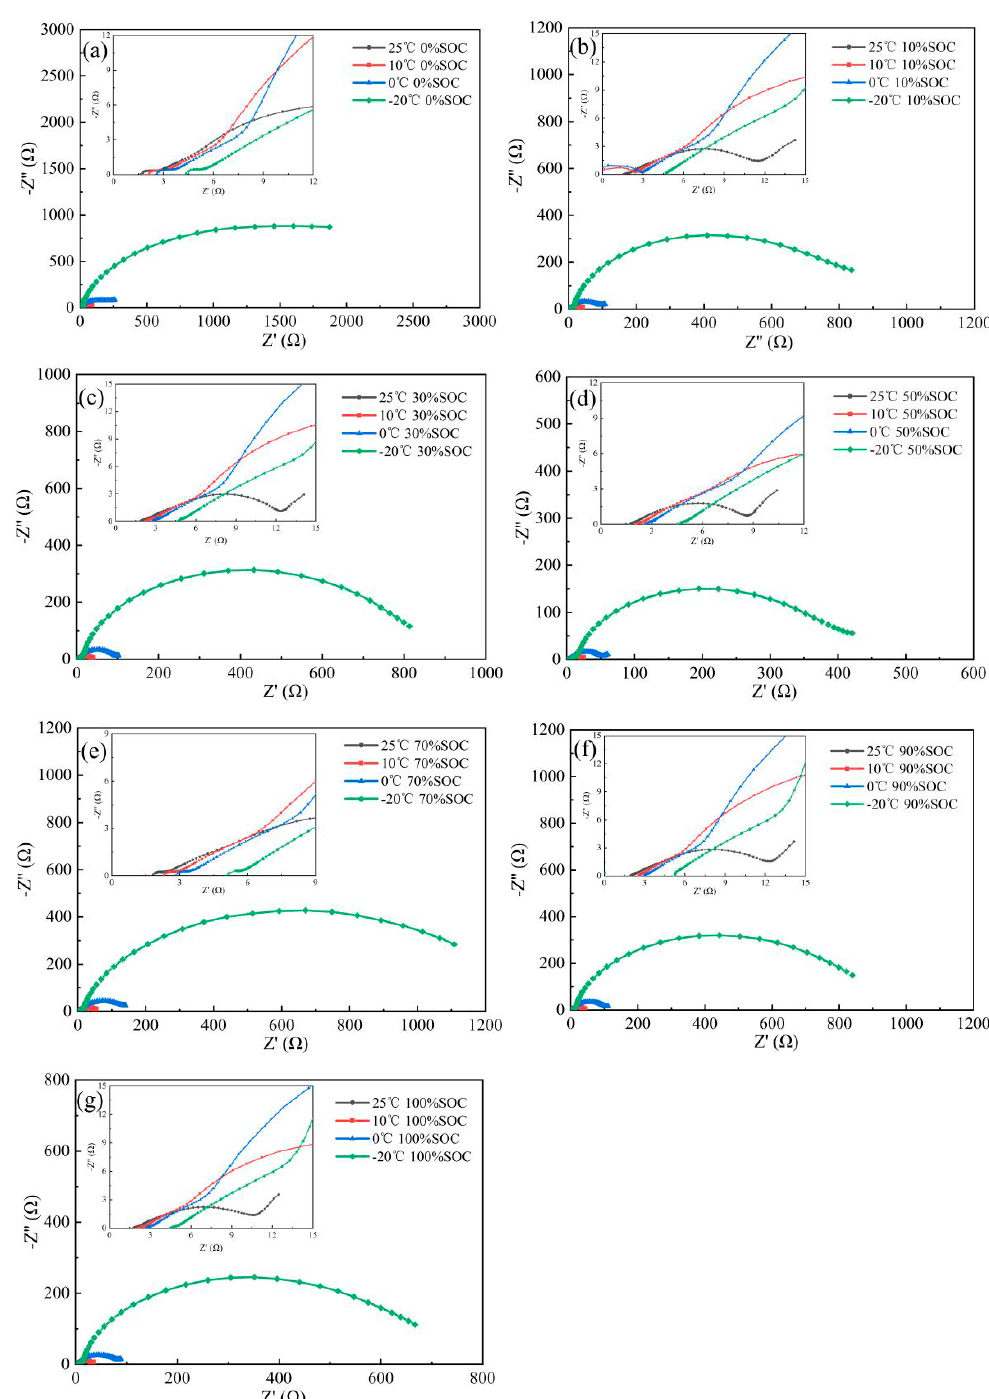
Figure 7. EIS spectrum of the NCM523 ( a ) 0% SOC; ( b )10% SOC; ( c ) 30% SOC; ( d ) 50% SOC; ( e ) 70% SOC; ( f ) 90% SOC; ( g ) 100%